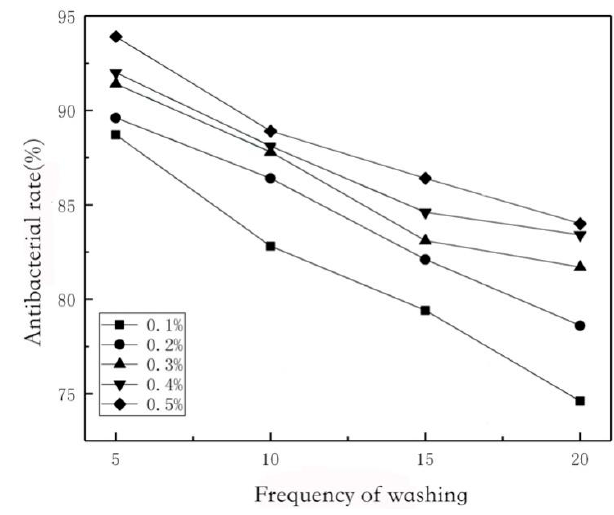
Figure 9. Washing resistance antibacterial rate of CS / Gr modified bamboo fiber fabrics (CGBFs) with different graphene additions.